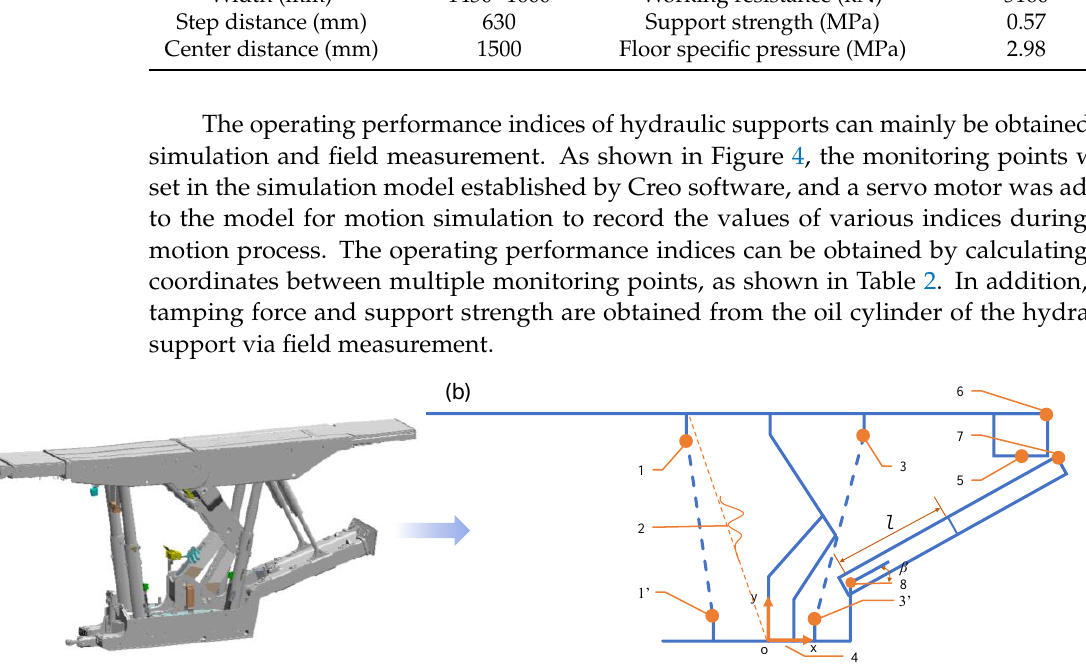
Table 1. Parameters of filling hydraulic support.